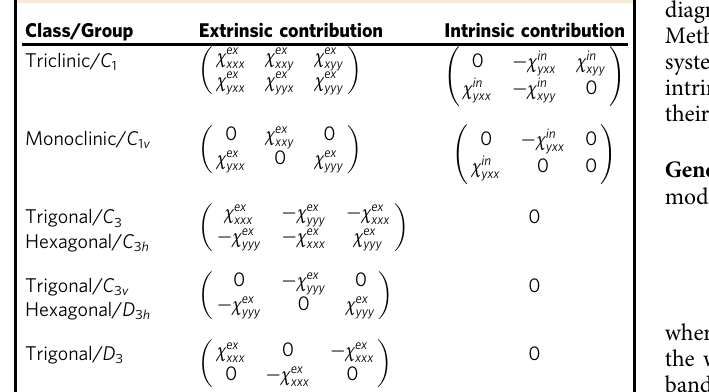
Table 1 Nonzero nonlinear Hall response elements in 32 point groups (2D). The matrices are de fi ned in Eq. 10. The elements that exist in χ ex but vanish in χ in are highlighted in bold. The C n axis is assumed in order as the z -, x -, and y - axis, the mirror plane σ v is assumed in order as the yz - and xy zx -plane and the mirror plane σ h is assumed as the